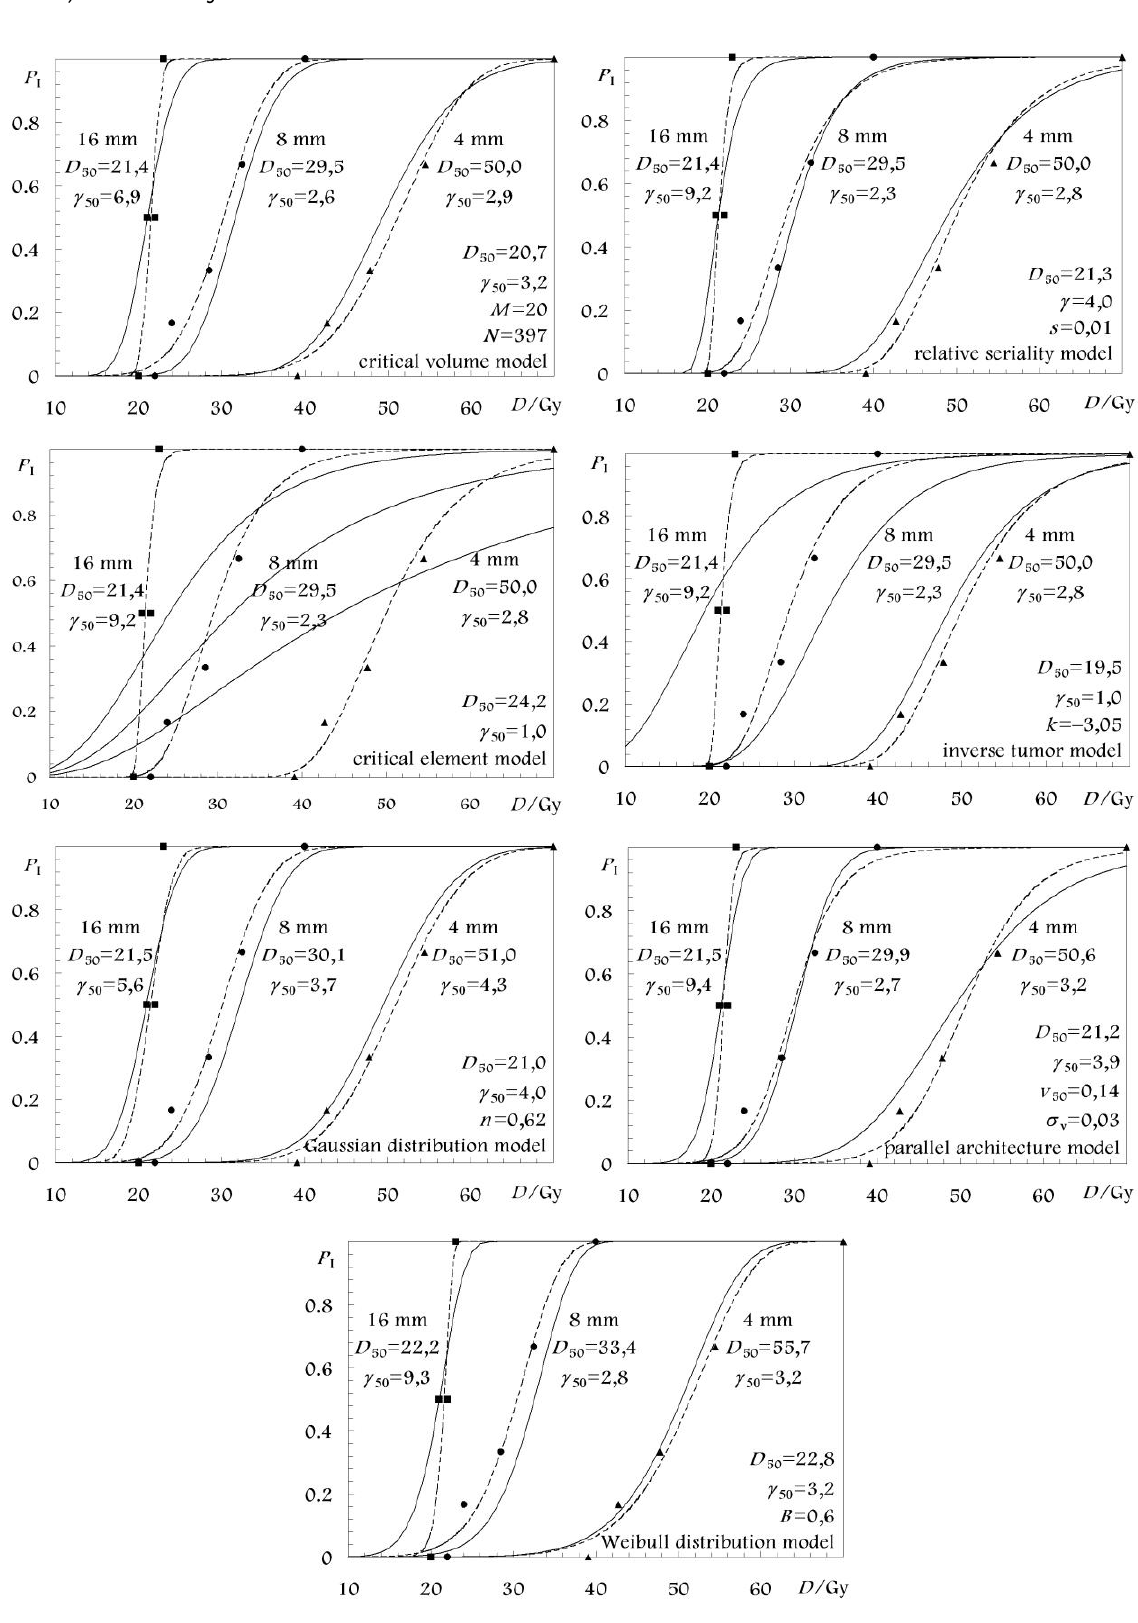
Figure 2. Volume and dose-response curves for white matter necrosis of different lengths of rat cervical spinal cord. The solid lines give the combined best fitting. The dashed lines have been fitted to each of the irradiated spinal cord segment lengths separately, i.e. , without any volume